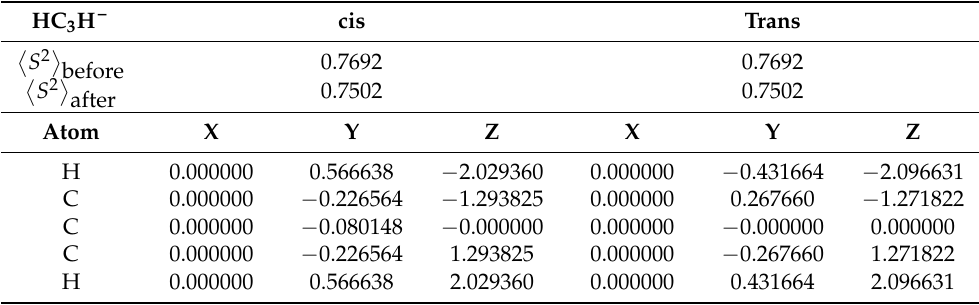
Table A2. Cartesian coordinates in Å of the cis and trans HC 3 H – anion conformers optimized at